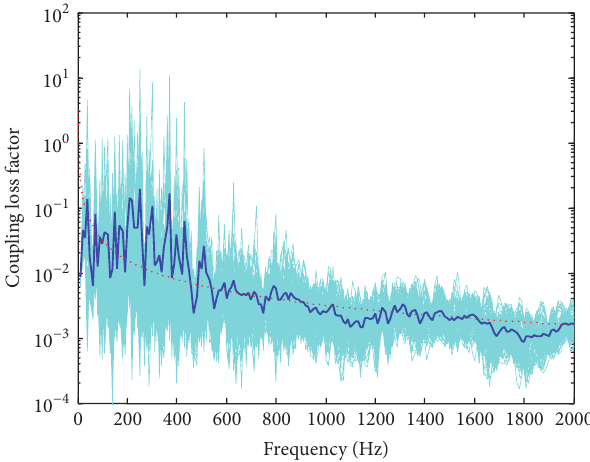
Figure 6: Comparison of 𝜂 12 when 𝑁 = 2 (widely-spaced): PIM simulations (real thin lines); ensemble average of the PIM solutions (thick real line); (43) (dotted line).